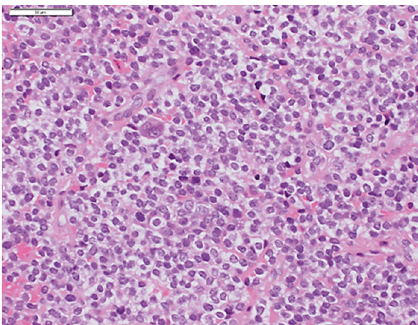
Figure 4: The tumor cells are small and round shaped and have abundant glycogen.